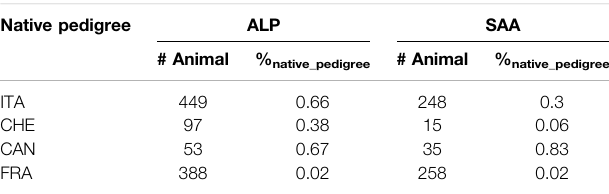
TABLE 4 | Count of genotyped animals recorded in several countries for each national pedigree independently of the origin of the animals. The proportion of these animals compared to their native pedigree is represented in the columns % native_pedigree .